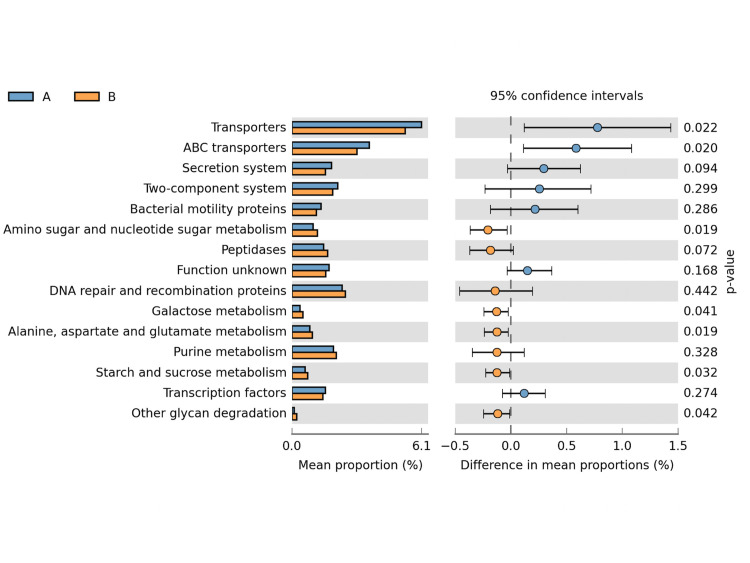
Microbial community functional prediction.Gut microbiota functional predictoin, using PICRUSt, of infants with early or late HC catch up. The bar plot respresents function mean proportion, and error bars represents the difference between the two groups. Coloring of the error bar is according with the group with the higher proportion of the respective function. Blue color (A) represents infants with HC catch up until 6 months, and Orange (B) represents those with HC catch up after 6 months of age.